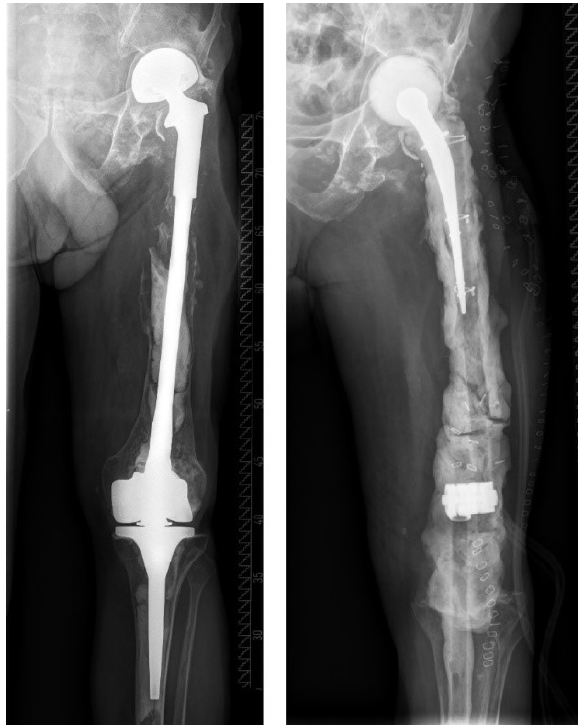
Figure 6. This patient was diagnosed with a chronic PJI of his total femur prosthesis (“p2”) and underwent first-stage surgery with implantation of a custom-made double-level spacer (hip and knee spacer of the same leg). Because of the patient’s high perioperative risk (“M2”) and low physical demand, a shared decision was made to not perform second-stage